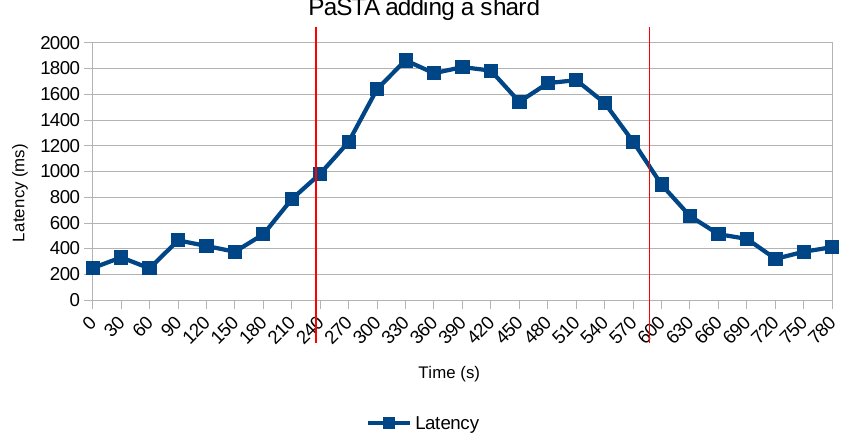
Figure 15. Time required before sharding becomes